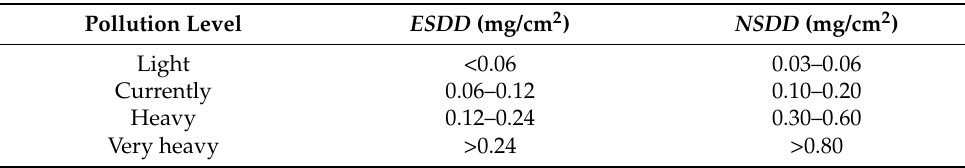
Table 1. Pollution levels based on IEC